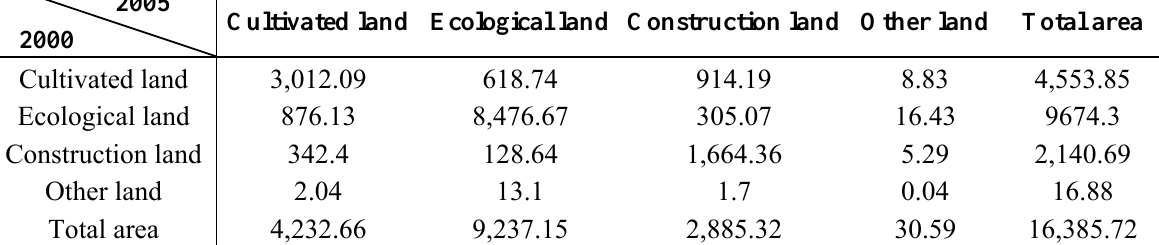
Table 3. Transition matrix of land use change from 2000 to 2005 in Beijing (km 2 ).